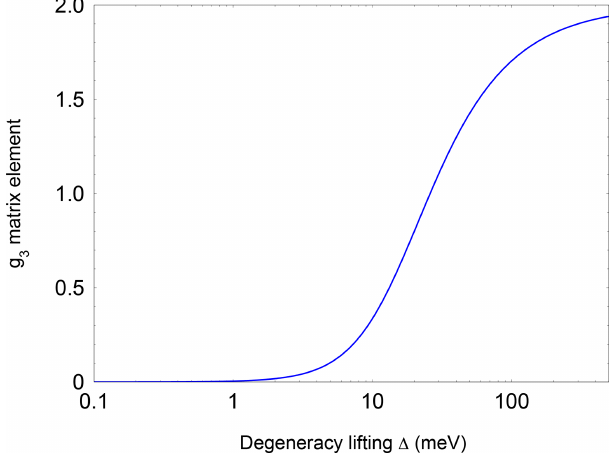
Figure A3. Dependence of the pseudo-axial g 3 matrix element of the NO radical as a function of 2 π ∗ x and 2 π ∗ y level